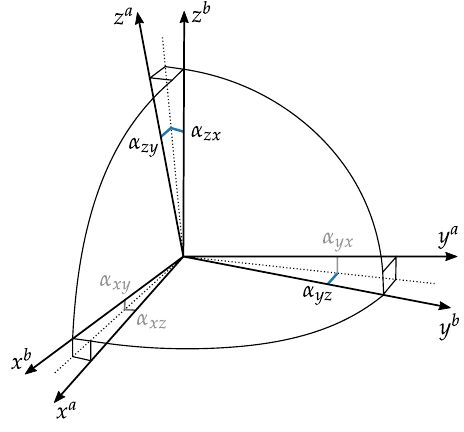
Figure 3. The non-orthogonal sensitivity axes a can be transformed to the orthogonal body frame b by 6 small angles (after Reference